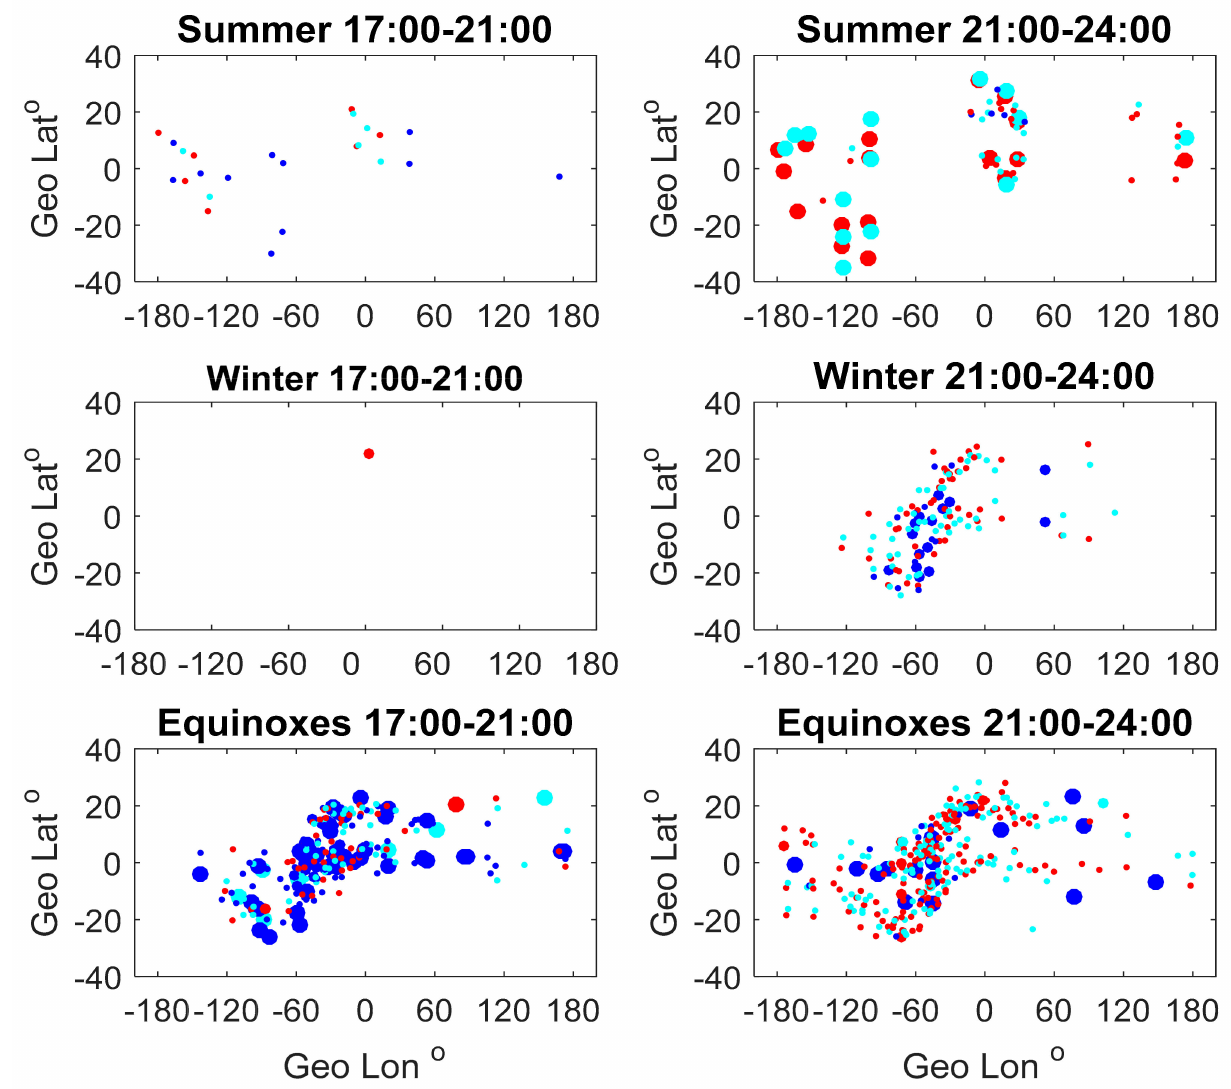
Figure 8. Shows the geographic distribution of IBIs at different seasons and local times. Rows from top to bottom corresponding to summer, winter, and equinoxes. Left and right columns corresponding to sunset (17:00–21:00) and pre-midnight (21:00–24:00) local times. IBIs observed by Swarm A, B, and C are marked in red, blue, and cyan colors, respectively, and sizes of the circles from small to large correspond to the storm levels of moderate to